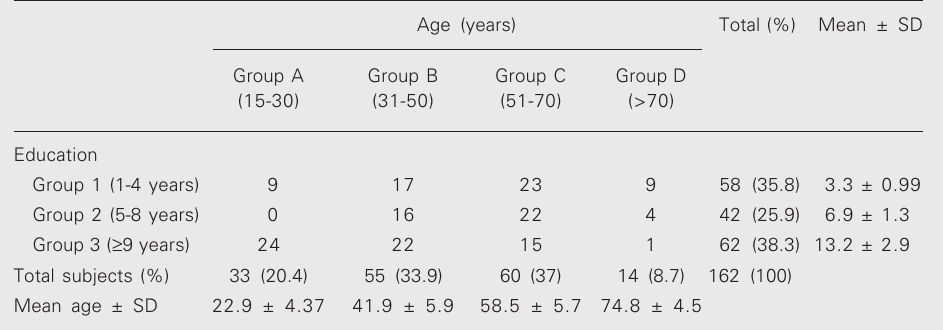
Table 1. Demographic data of the study